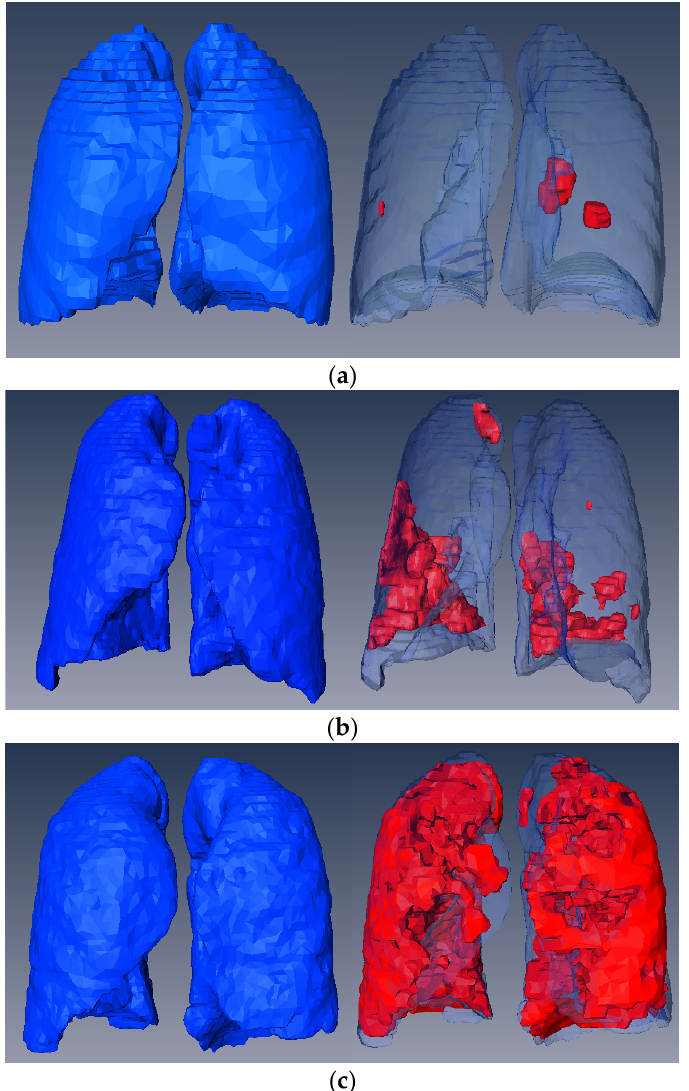
Figure 6. Volume reconstruction of the lungs and its correspondent infection regions of: ( a ) a patient presenting a mild infection; ( b ) a patient presenting a moderate infection; ( c ) a patient presenting a severe infection.